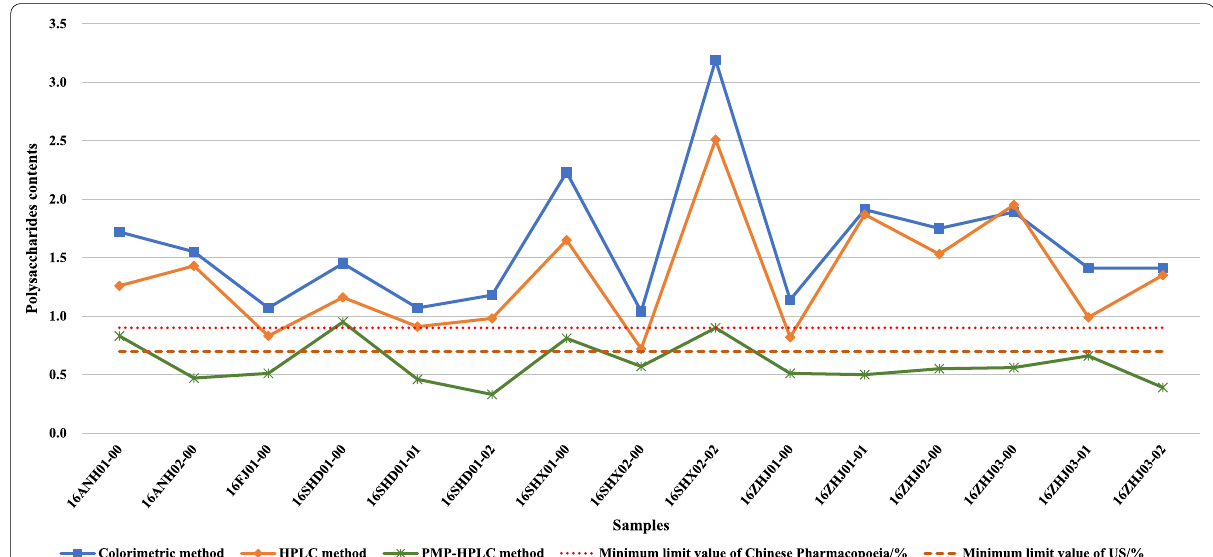
Fig. 6 Polysaccharides contents extract from fruit body of 15